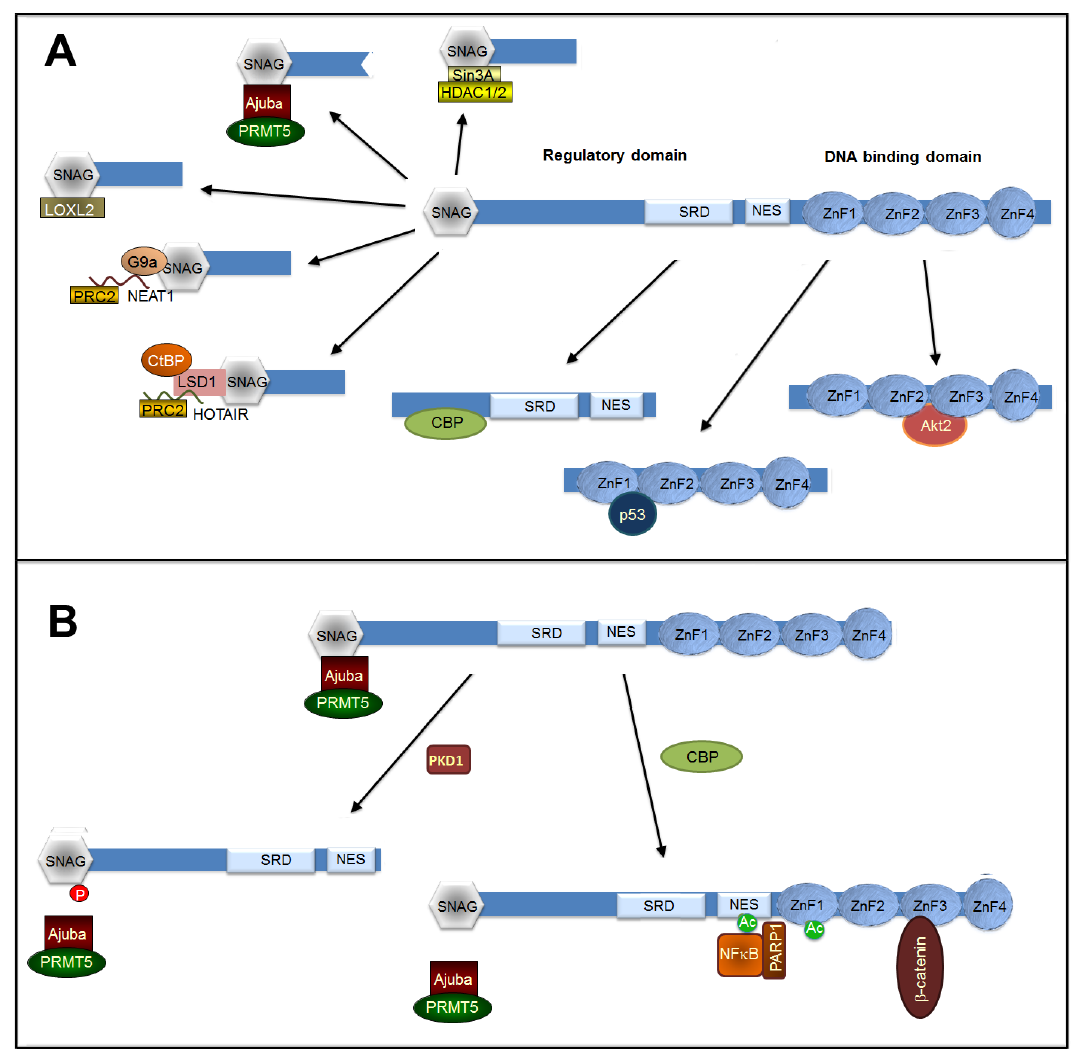
Figure 2. Transcriptional cofactors required for Snail1 function. The figure shows a diagram of Snail1 protein with the different corepressors interacting with the SNAG domain ( A ). The binding sites for CBP (required for Snail1-induced activation or mesenchymal genes), p53, and Akt2 are also shown. Other factors also interacting with Snail1 but with still uncharacterized sequences are not shown. In panel ( B ), the effect of PKD1-induced phosphorylation of S11 in the SNAG sequence on the interaction of Ajuba complex is presented. Moreover, this panel also illustrates the switch in Snail1 function promoted by the CBP-catalyzed phosphorylation of K146 and K187 that disrupts the association with Ajuba and facilitates binding to the p65 / NF κ B complex and presumably also to β -catenin. The Snail1 element interacting with NF κ B has not been characterized; binding to β -catenin has been allocated to the C-terminal domain, likely to ZnF3 and -4 (see text).